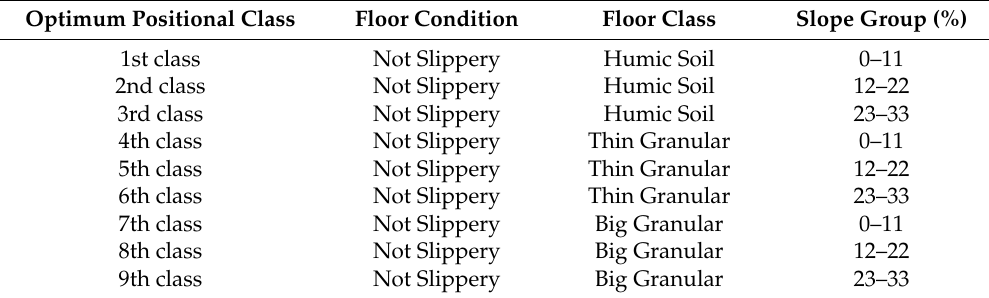
Table 1. Spatial class layer definitions.